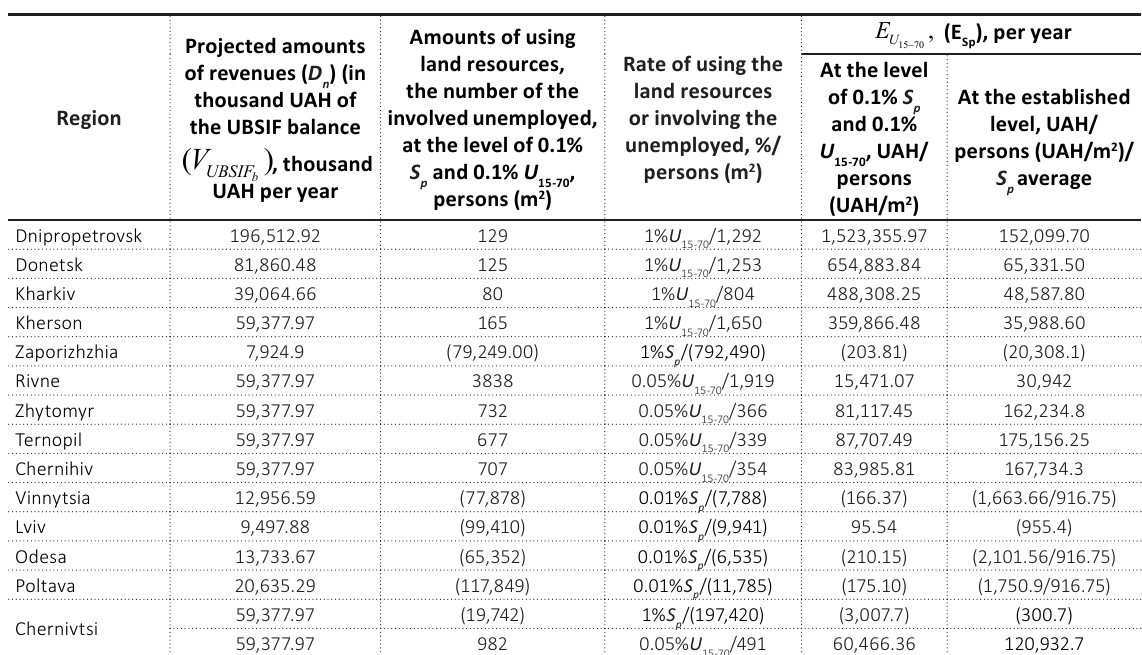
Table 3. Indicators of the efficiency of financial and economic regulation of land relations associated with the use of resources and involvement of the unemployed